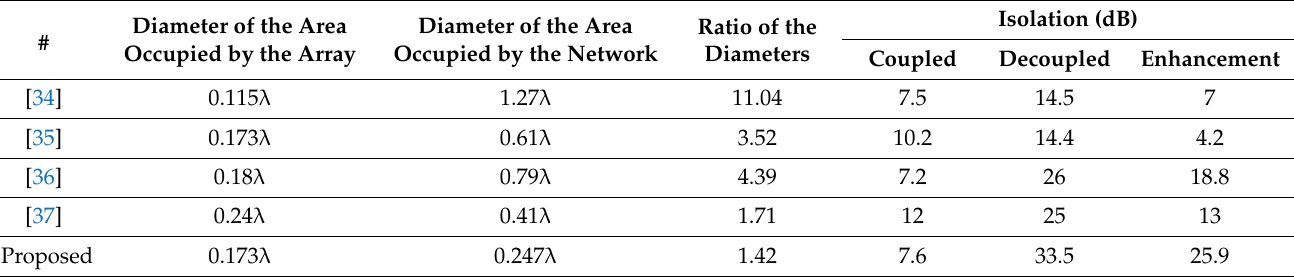
Table 2. Comparison of decoupling techniques for three-element